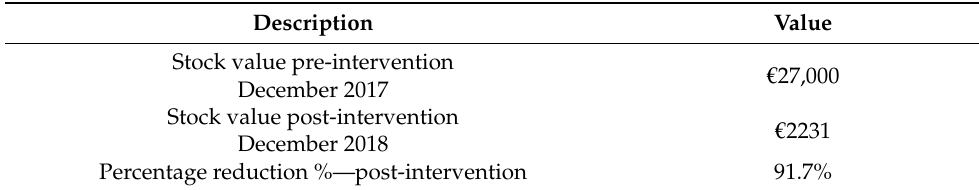
Table 5. Main storeroom end-of-year